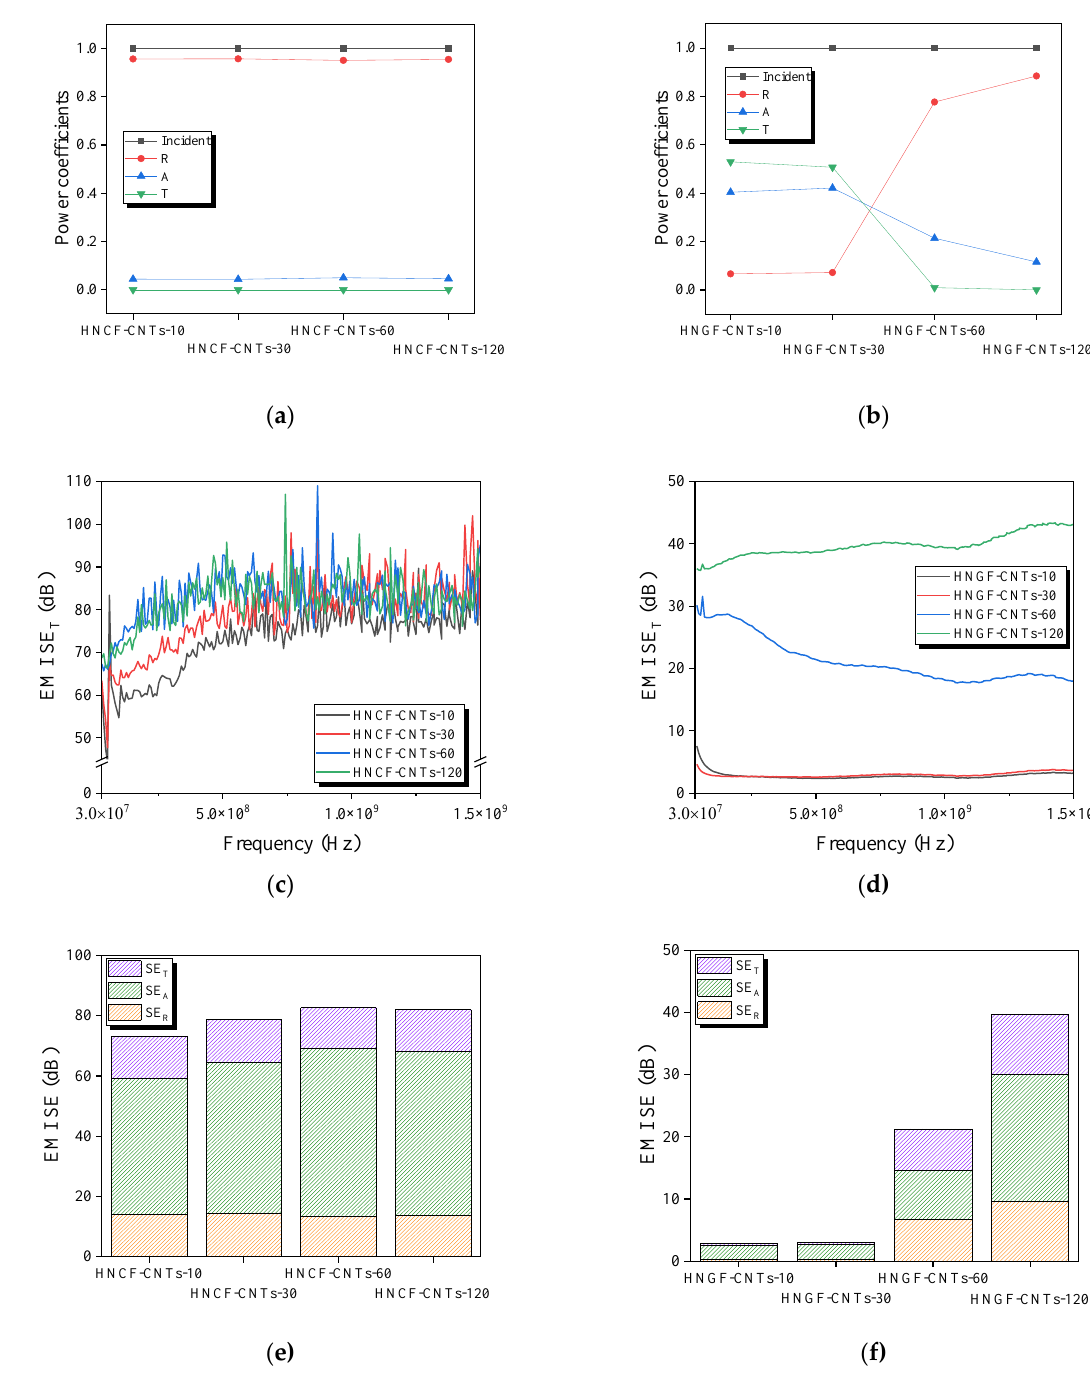
Figure 8. ( a , b ) Power coefficients of the CFRP and GFRP, respectively, with grown CNTs as a function of the plating time; ( c , d ) EMI SE T of the CFRP and GFRP, respectively, with grown CNTs as a function of the plating time; ( e , f ) Contributions of SE R and SE A to the SE T for CFRP and GFRP, respectively, with grown CNTs as a function of the plating time.